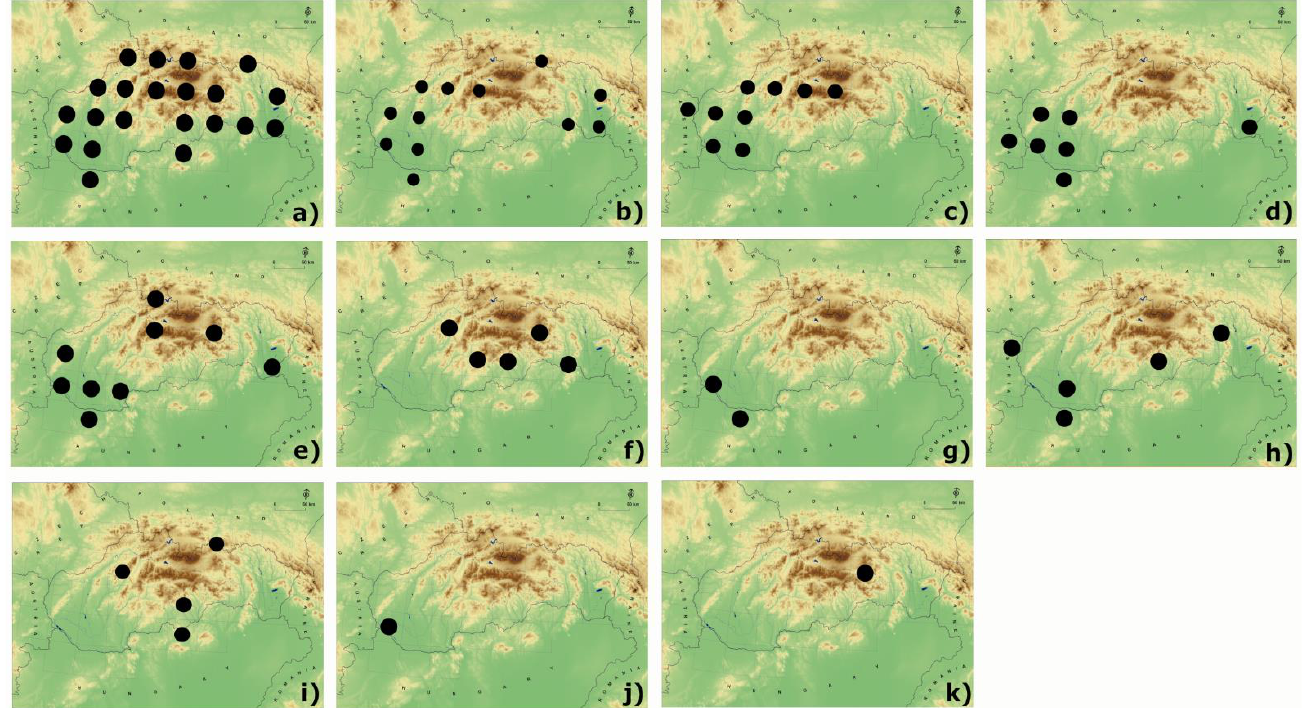
Figure 2. Distribution of individual charophytes in Slovakia (only species with the IUCN categories NT, VU, EN, and CR are listed) in AFE grid cells. ( a) Chara vulgaris , ( b ) C. globularis , ( c ) C. contraria , ( d ) C. hispida , ( e ) C. virgata , ( f ) C. gymnophylla , ( g ) Nitellopsis obtusa , ( h ) Nitella mucronata , ( i ) C. braunii , ( j ) Nitella syncarpa , and ( k ) C. canescens .